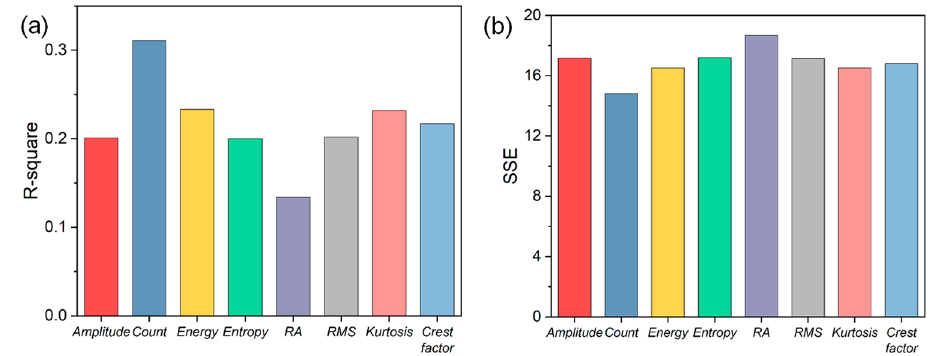
Figure 11. Linear regression results between crack growth rate and different AE parameters including the results of ( a ) R-square and ( b ) the sum of squares due to error (SSE).